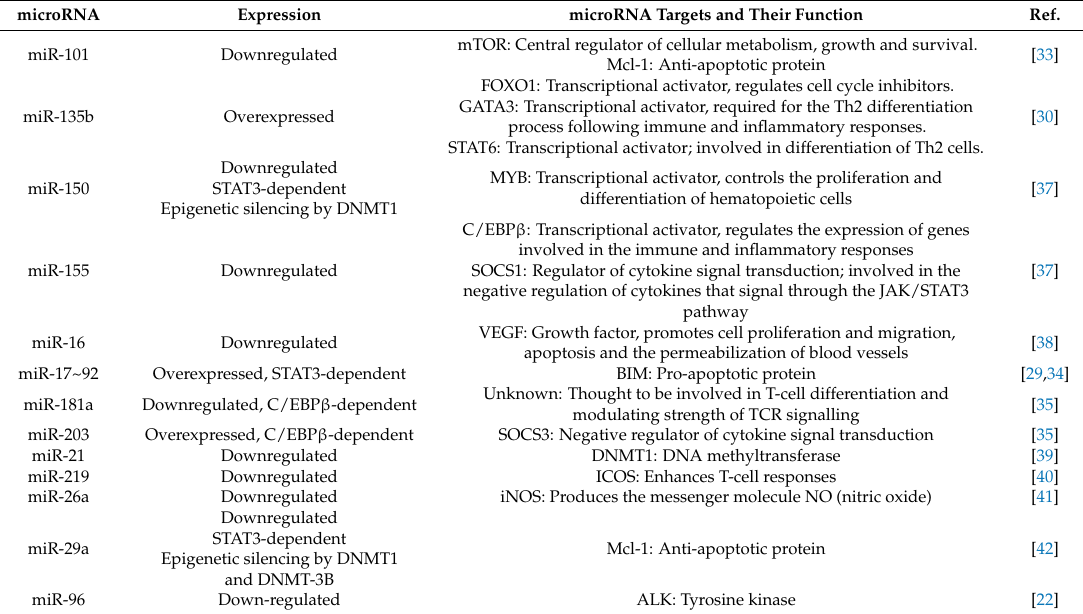
Table 2. List of microRNA (miRNA) whose expression is dysregulation in ALK(+) ALCL. microRNA Expression microRNA Targets and Their Function Ref. miR-101 miR-135b